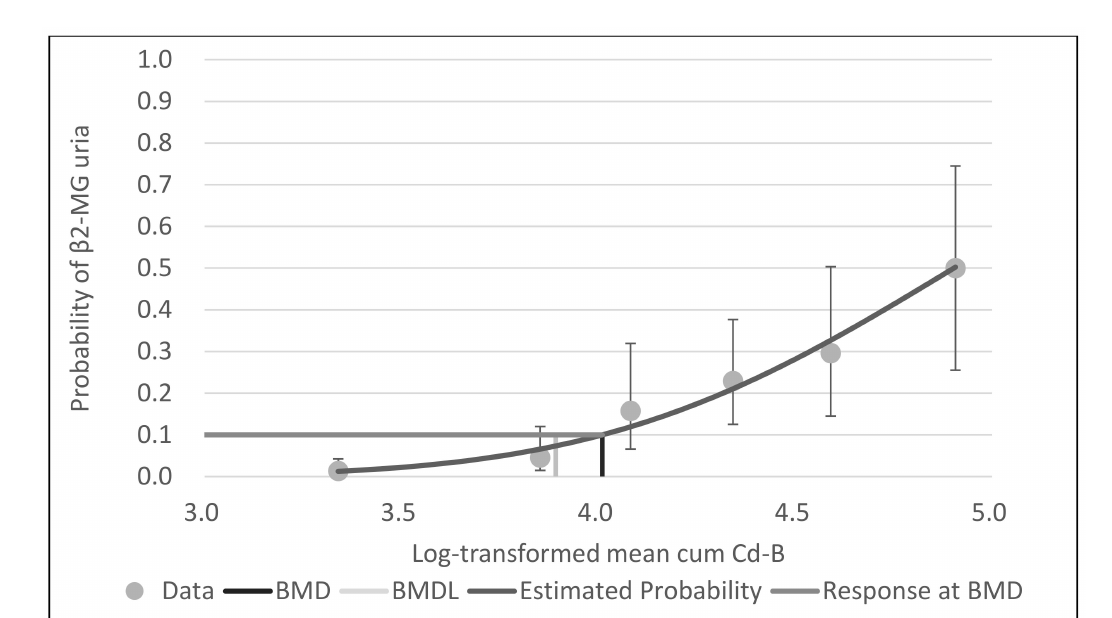
Figure 2. Probit model with BMR of 10% extra risk for the BMD and 95% lower confidence limit for the BMDL of log-transformed mean cum Cd-B for β 2-MG